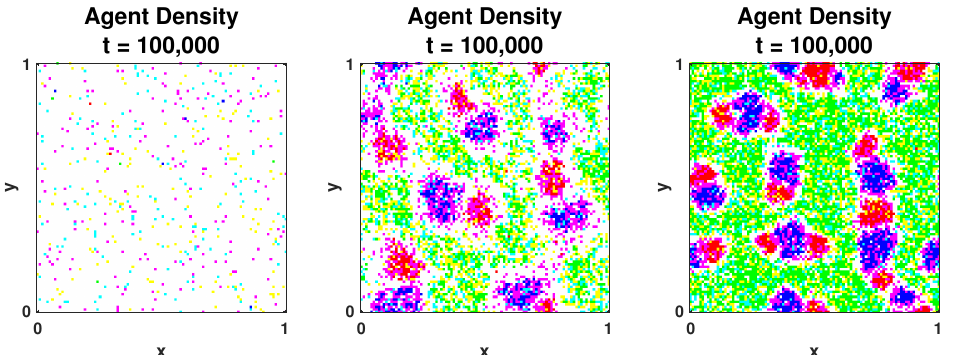
Figure 19. Agent density lattices for the second variation (Threat Level) taken after 100,000 time steps = 1, and N = N = N = 50,000 agents. On all lattices, the first and second β for δ t = 1, L = 100, γ 2 3 1 λ values were fixed to β 1 = 6 × 10 − 6 , β 2 = 8 × 10 − 6 . Starting from the top left, the third β value used was 1 × 10 − 5 ,2.2 × 10 − 5 and β 3 = 3 × 10 − 5 , respectively. The color of gang 1 is red, while gang 2 and 3 colors are blue and green, respectively. In the first lattice, β 1 β 2 β 3 < β ∗ , and this resulted in the agents being well-mixed. In the second and third lattice, β 1 β 2 β 3 > β ∗ , and this resulted in the agents